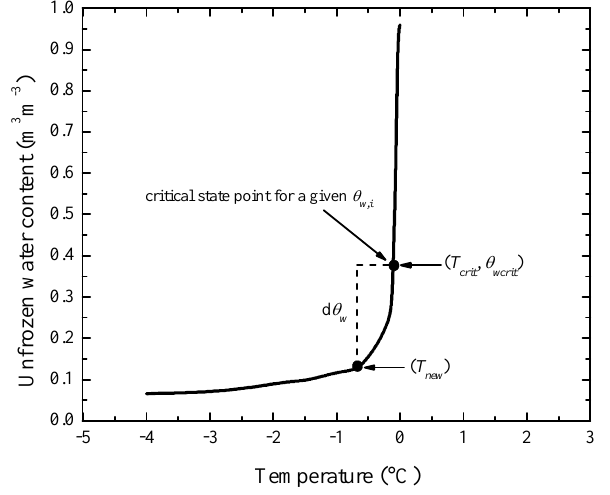
Figure 3. Graphical description of the phase change approach used in this study. The curve is a soil freezing curve for a hypothetical soil. The change in water content (d θ w ) due to Q res ,i is used to determine T new by integrating along the SFC (Eq.